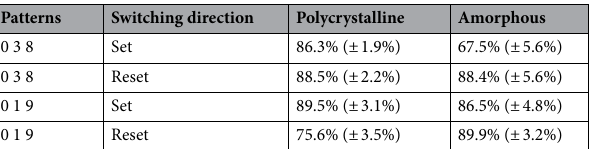
Table 1. Recognition rates of experimental stochastic learning. The recognition rates for both pattern sets determined with both switching directions of the polycrystalline and amorphous devices are shown. Every learning was performed in 5 epochs using the averaged MNIST learning data. Declared are mean values and standard deviations of 5